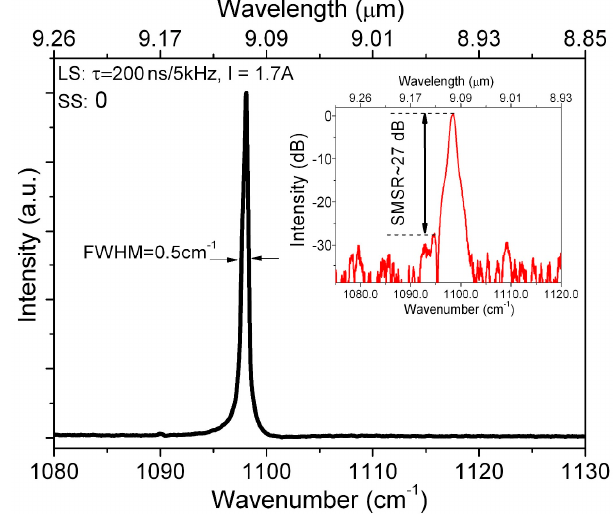
Figure 6. Room temperature single mode emission spectrum of RIE fabricated CC-QCL. The laser was driven with 1.7 A current applied to the long section. The short section was unbiased.